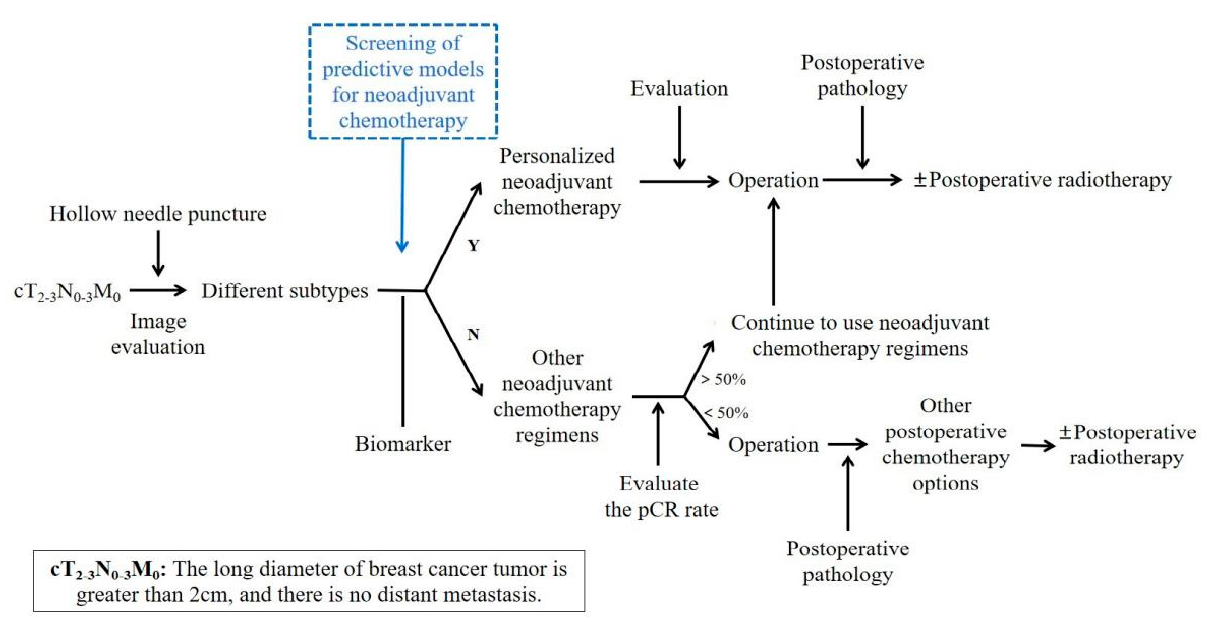
Figure 1. Personalized neoadjuvant chemotherapy.